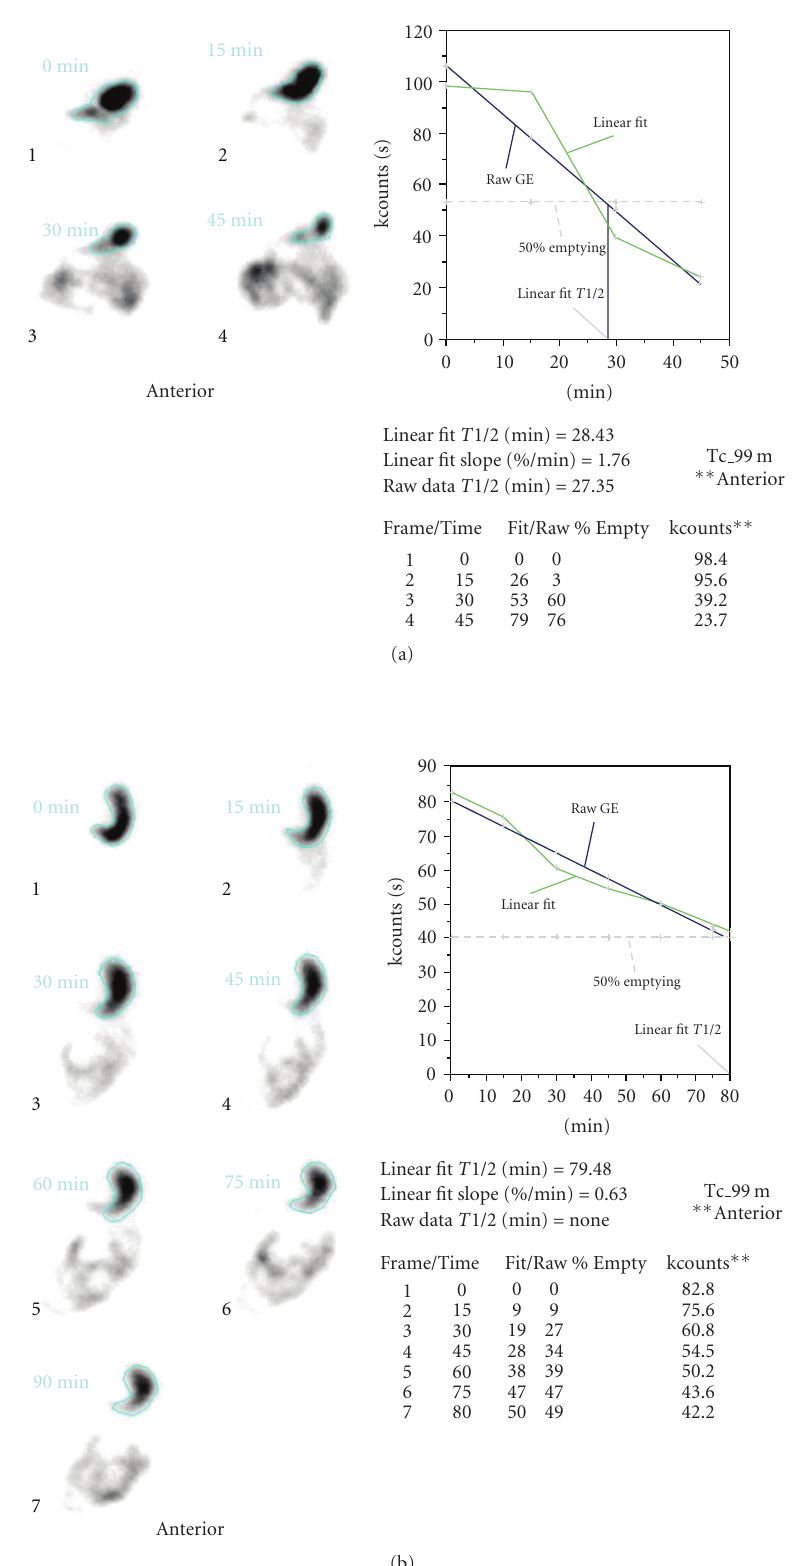
Figure 2: (a) The normal gastric emptying half-time (T50: 28.43 min) in a healthy case of control group. (b) The delayed gastric emptying half-time (T50: 79.48 min) in a hypothyroid